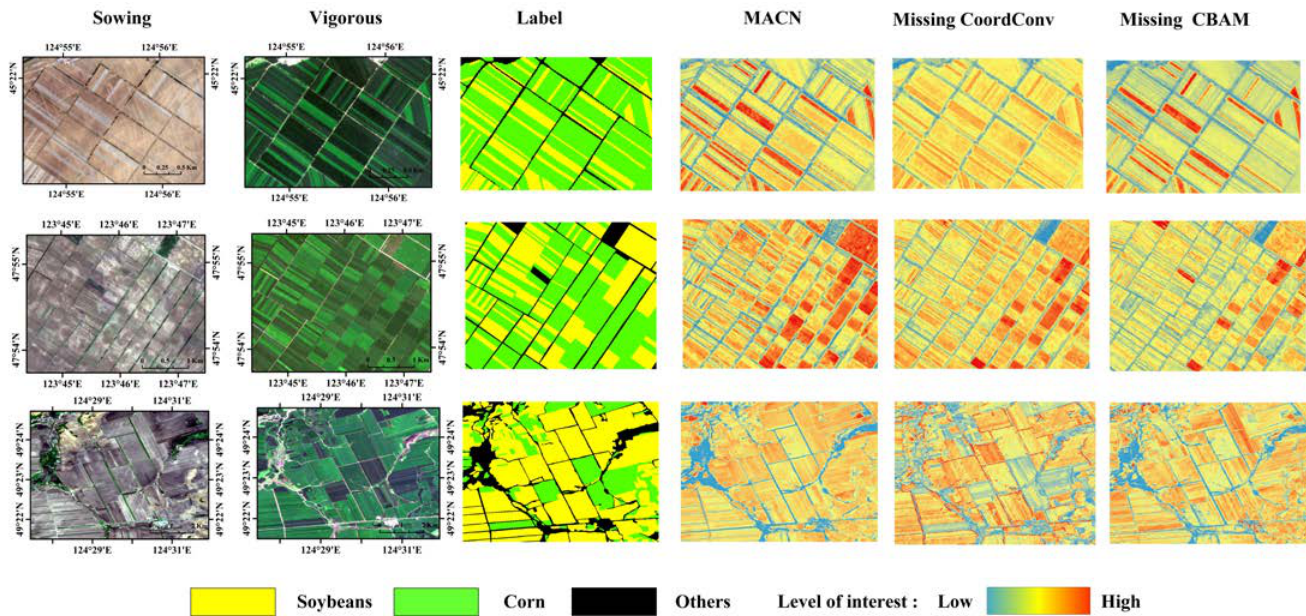
Figure 14. The feature maps of MACN, Missing CoordConv and Missing CBAM.